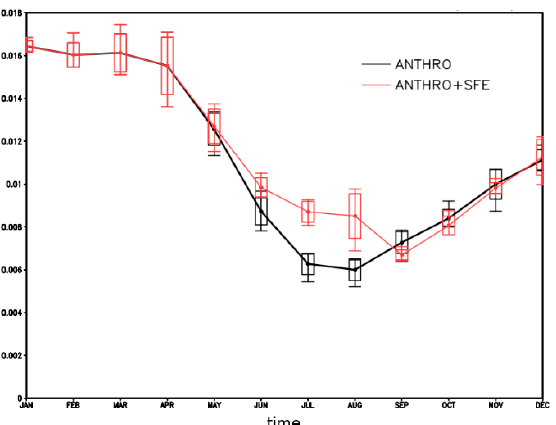
Figure 10. Annual variation of the total BC burden in the Arctic in Tg. Black curve—anthropogenic emissions, red curve—anthropogenic and fire components. Points—mean values for the ensemble, bars—standard deviation, segments—maximum and minimum values for the ensemble.